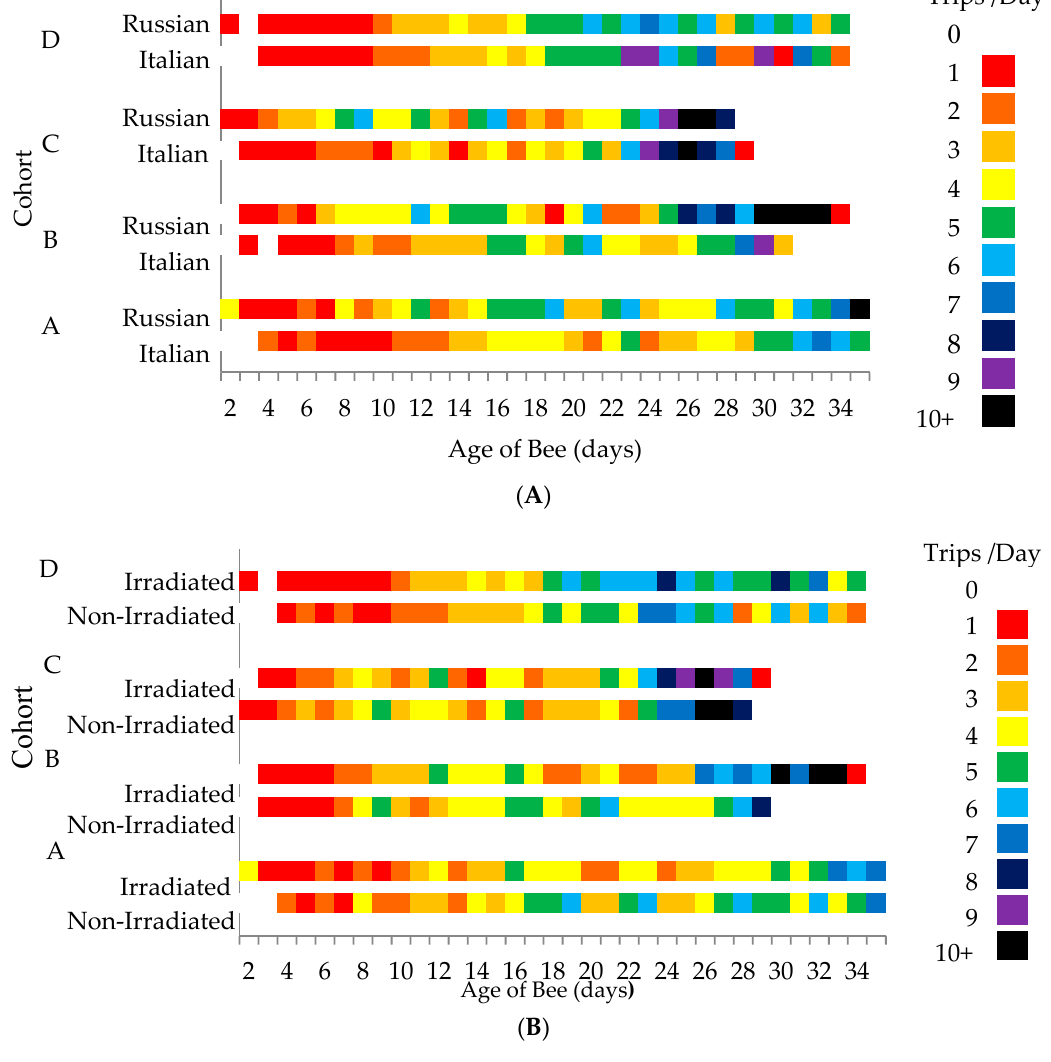
Figure 2. Number of daily flights of Russian and Italian honey bees ( A ) and bees that were reared from irradiated and non-irradiated combs ( B ) through time. Cohorts of bees were introduced into a host colony at different times.